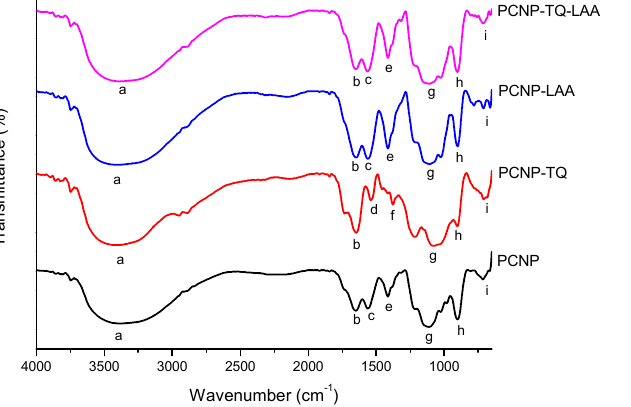
Figure 5. Fourier-transform infrared spectroscopy (FTIR) spectra of PCNP, PCNP-TQ, PCNP-LAA and PCNP-TQ-LAA. The labelled peaks that represent certain functional groups are stated in Table 2.